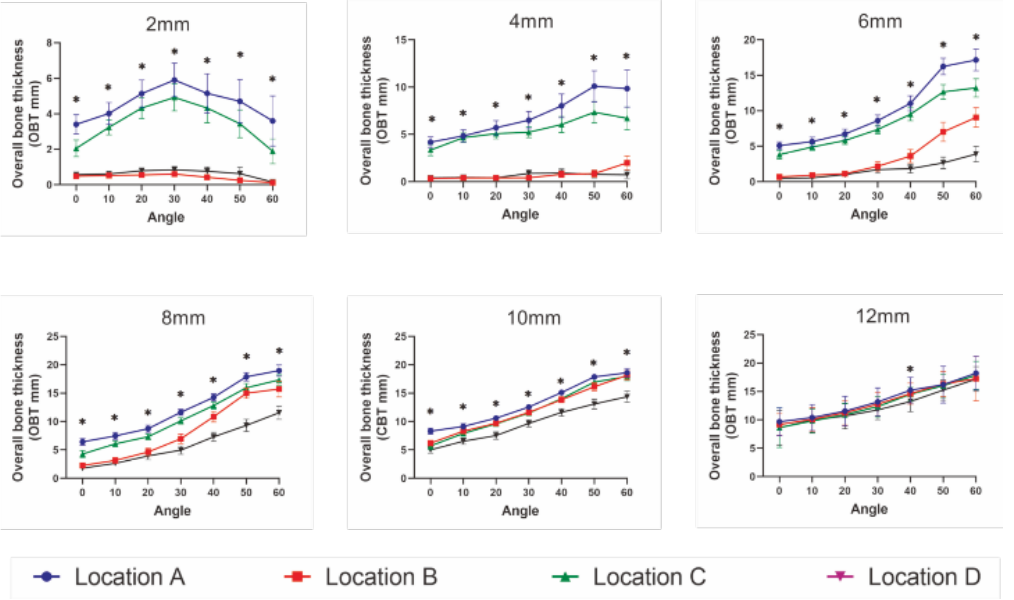
Figure 5. Comparison of the overall bone thickness (OBT) among four insertion locations at each insertion height. * p < 0.05, statistical significance among four sites.